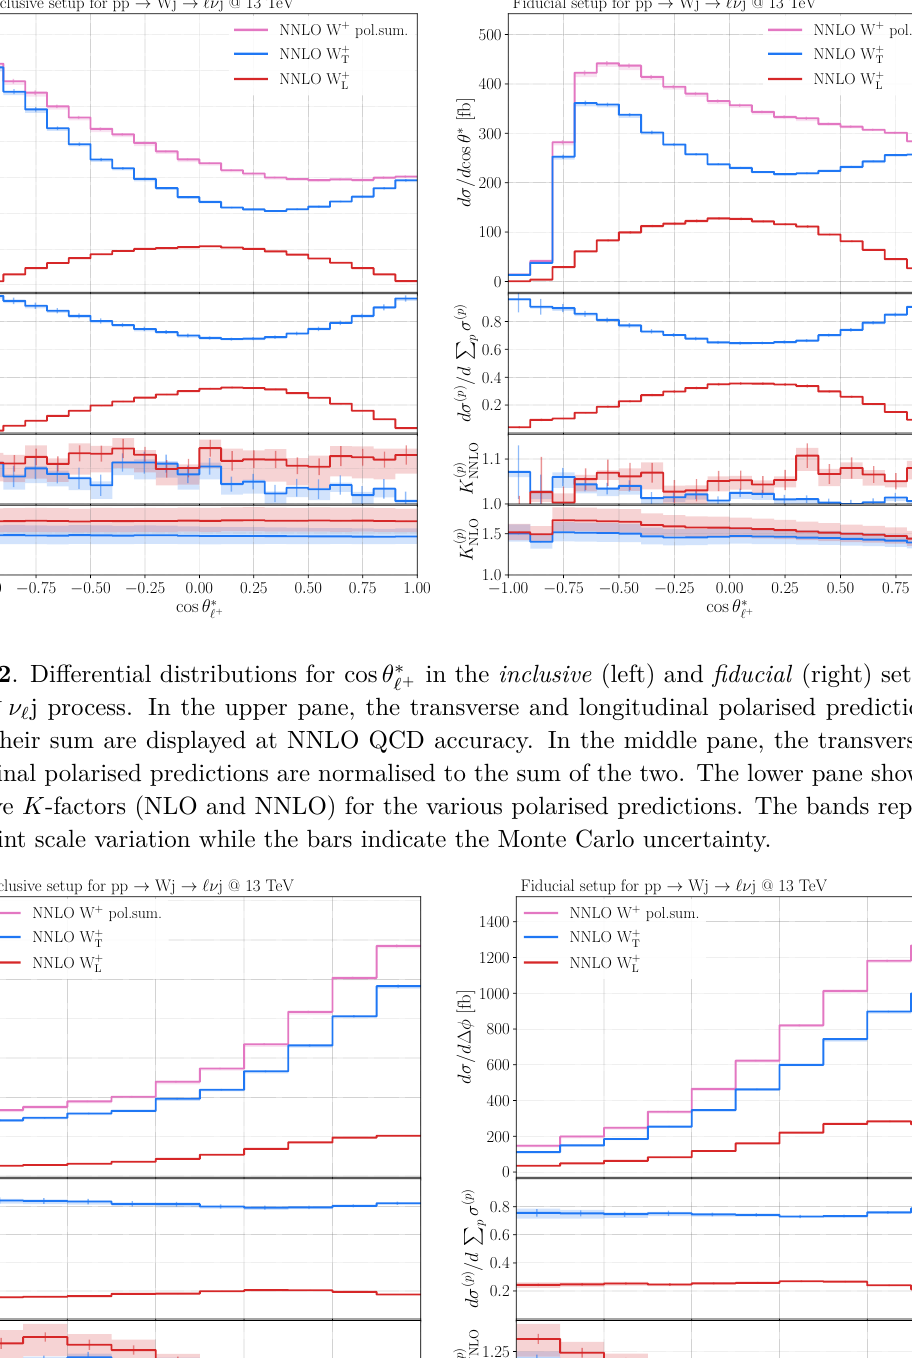
Figure 3 . Differential distributions for ∆ φ ( ‘ + , j